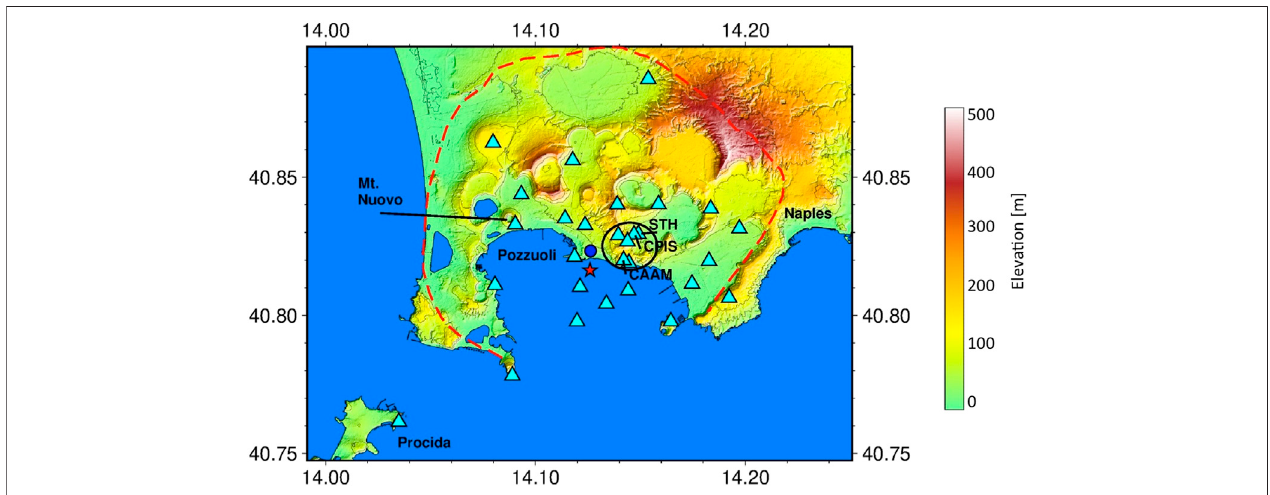
FIGURE 3 | Map of Campi Flegrei. The cyan triangles indicate the seismic network stations. STH (catalog reference station) and CPIS (used for calculating the fumarolic tremoramplitude)stationsareindicatedonthemap.ThebluecircleindicatestheRITEGPSstation.Theredstarmarkstheareaofmaximumuplift(Iannaccone et al., 2018). The red dashed line indicates the edge of the caldera. The black ellipse encloses the hydrothermal area of Solfatara-Pisciarelli. Monte Nuovo is the cone formed in the last eruption